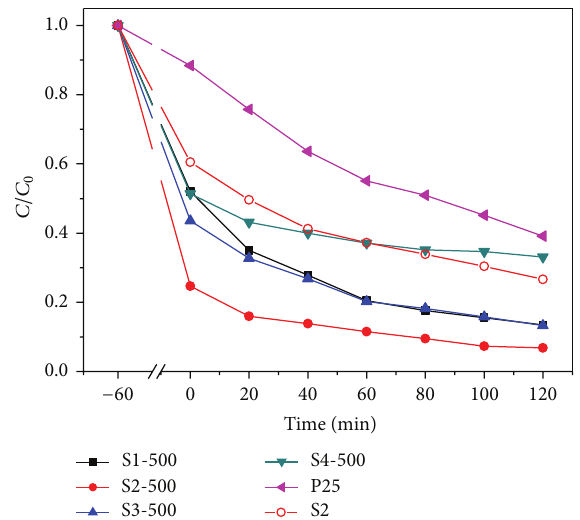
Figure 5: The photocatalytic performance of samples.